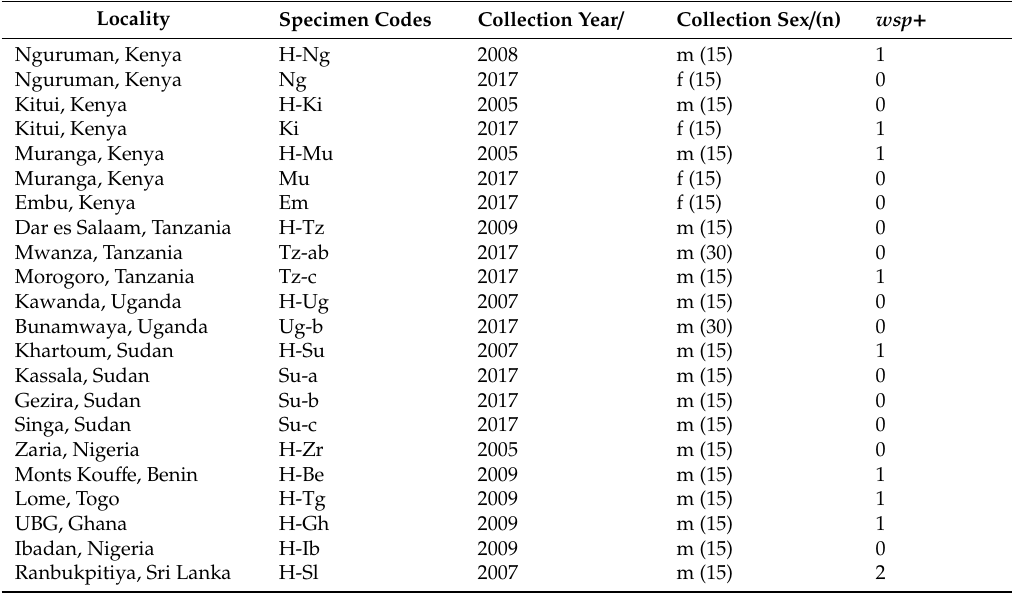
Table 1. B. dorsalis populations screened for Wolbachia using wsp . Samples collected between 2005 and 2009 are preceded with “H” to distinguish them from those collected in